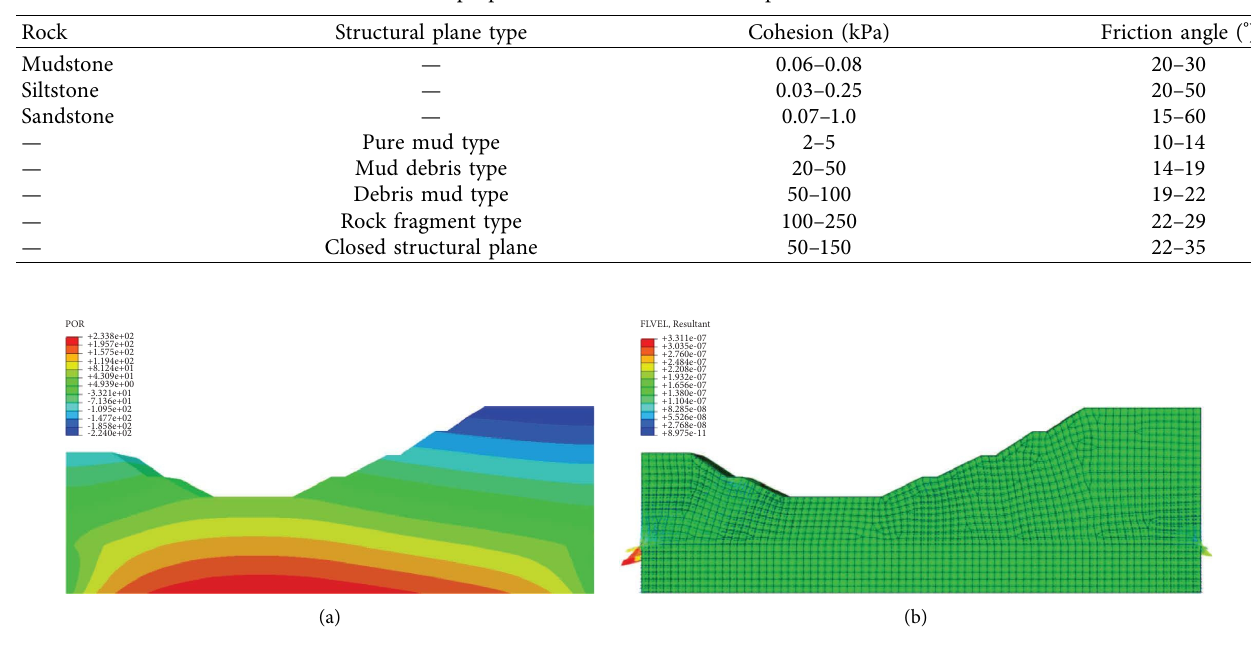
Figure 4: Numerical calculation model of Zhetang slope. (a) Conventional working condition; (b) check working condition. Table 4: Mechanical properties of common structural planes of red-bed soft rock.